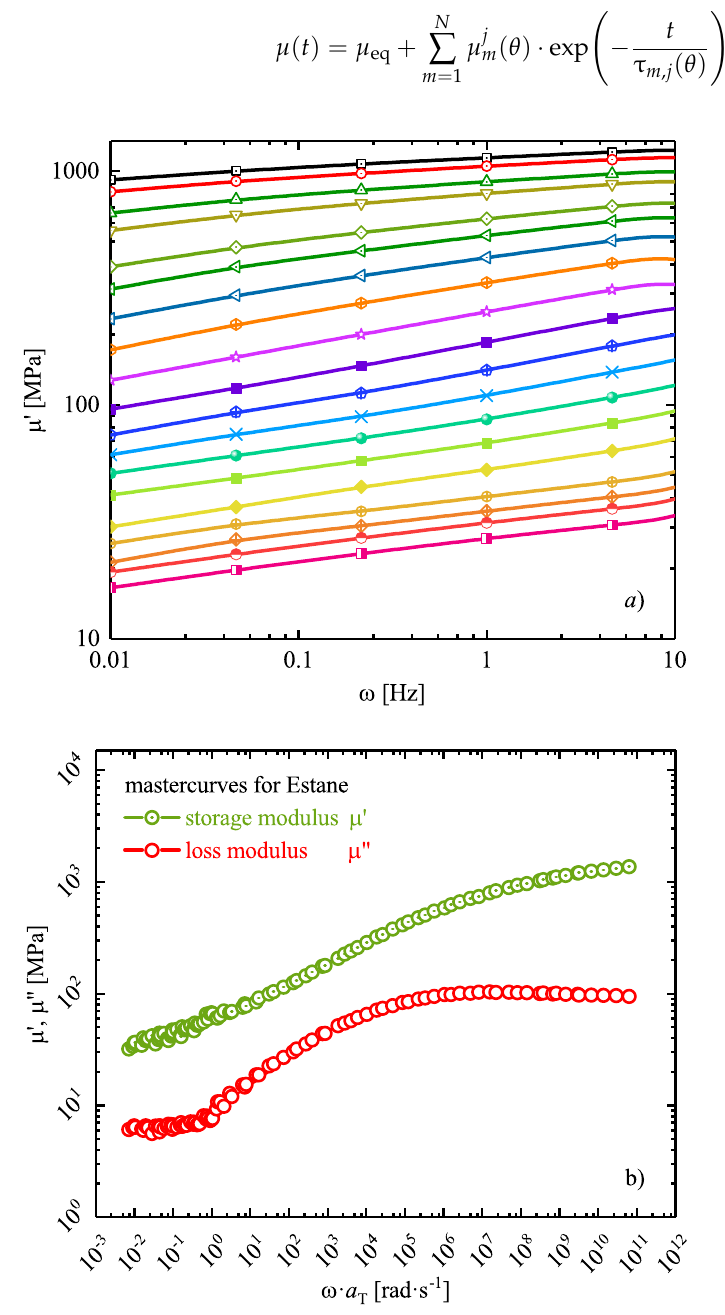
Figure 9. ( a ) Storage modulus as a function of frequency at different isothermal conditions obtained from Dynamic Mechanical Thermal Analysis (DMTA) experiments and ( b ) mastercurves of storage ( µ (cid:48) ) and loss moduli ( µ (cid:48)(cid:48) ) shifted to a reference temperature of θ ref = 50 ◦ . The solid line in the insert show the calculated shift factors obtained from WLF